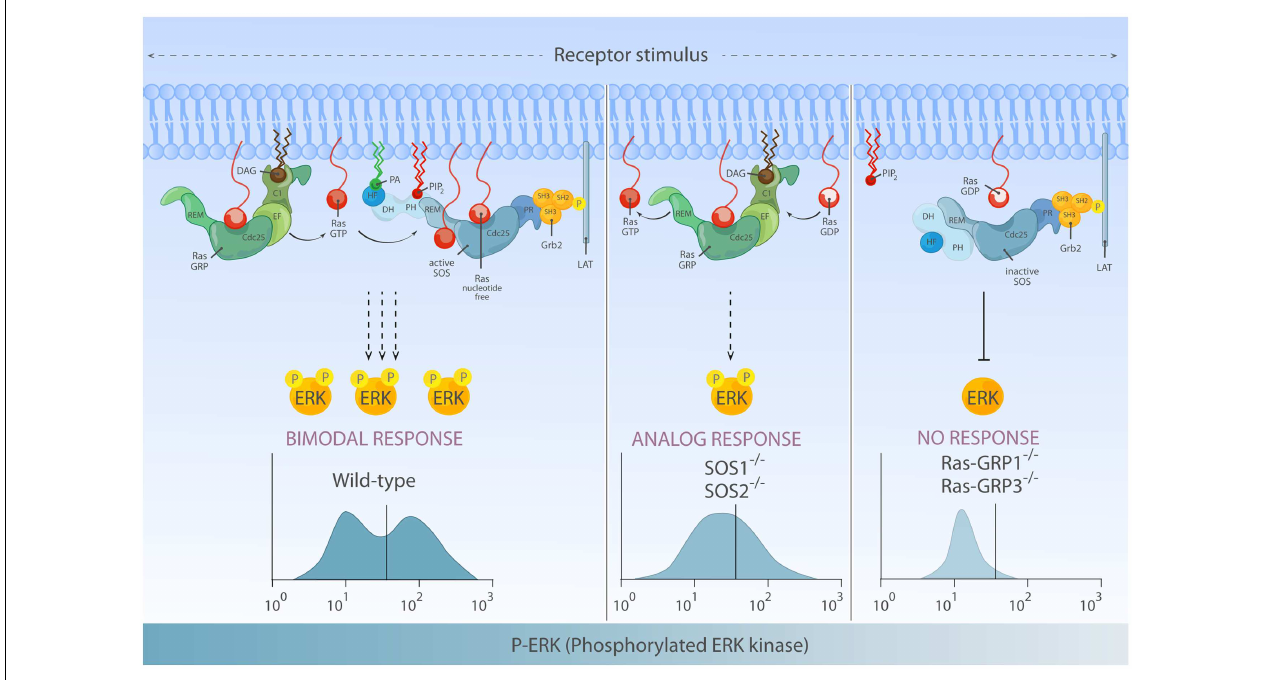
Ras-ERK activation mediated by RasGRP alone, but the ERK activation patterns are analog and therefore differs both quantitatively and qualitatively from ERK signal generated by two RasGEFs in synergy. Right: in lymphocytes, RasGRP plays a dominant role in connectingTCR-Ras-ERK pathway. SOS alone has difficulty to prime its own allosteric activation, which results in a high threshold for Ras-ERK